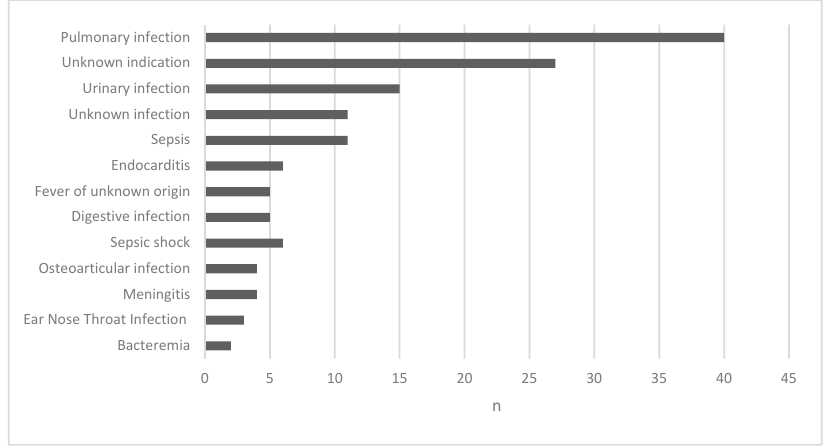
Figure 1. Number of serious reports of CNS ADRs related to ceftriaxone per indications.